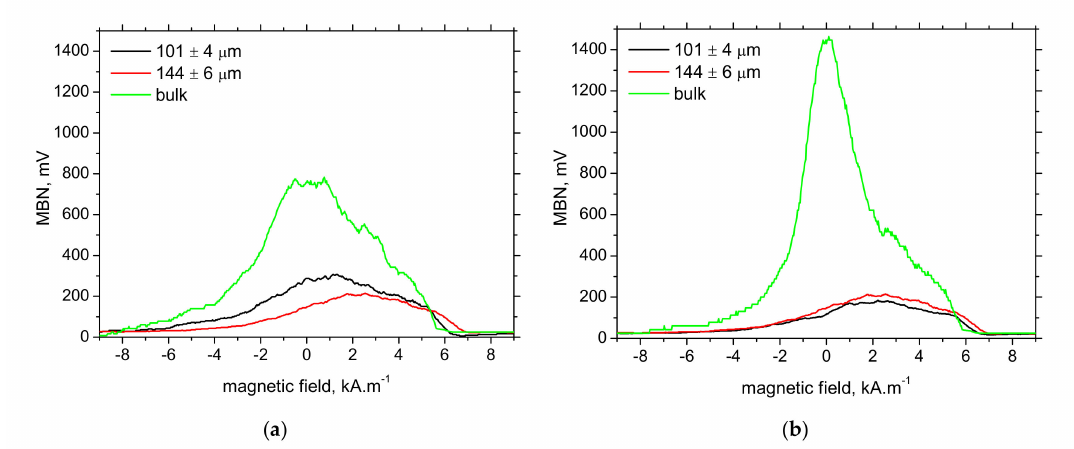
Figure 10. Evolution of MBN envelopes as a function of Zn coating thickness. ( a ) RD, ( b )